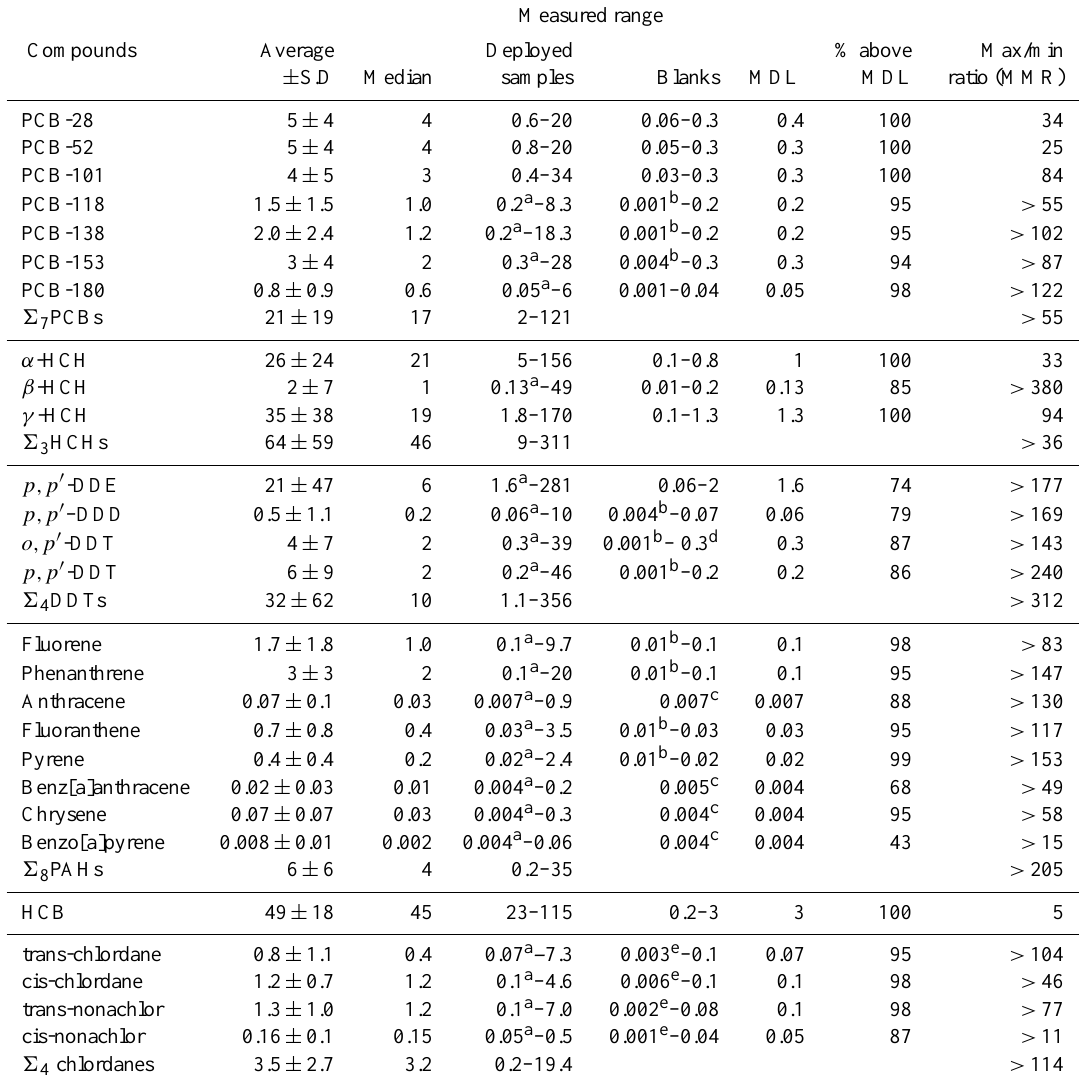
Table 1. Concentrations of selected PCBs, HCHs, DDTs, chlordanes and HCB (pgm − 3 ) and selected PAHs (ngm − 3 ) at European back- ground